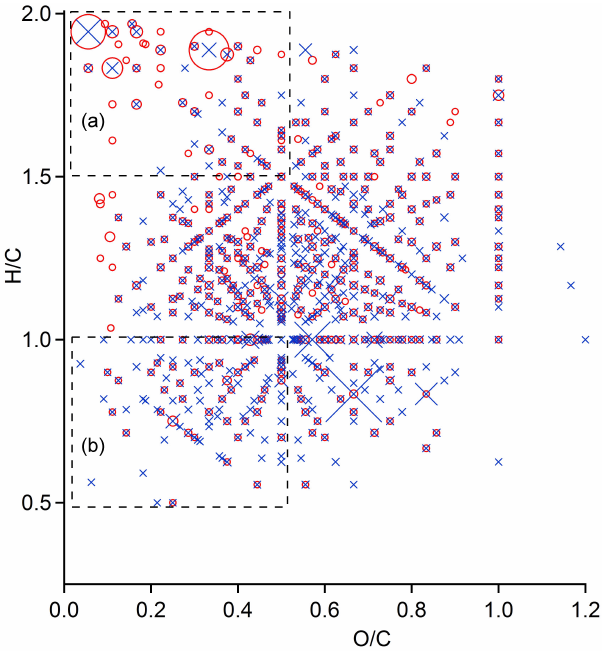
Figure 6. Overlaid Van Krevelen diagrams for CHON-containing formulae in the samples from the periods with low (red markers) and very high incidents (blue markers) of fires. The marker areas reflect relative ion abundance in the sample. Areas “A” and “B” indicate differences in the number of ions tentatively attributed to aliphatic and aromatic species,